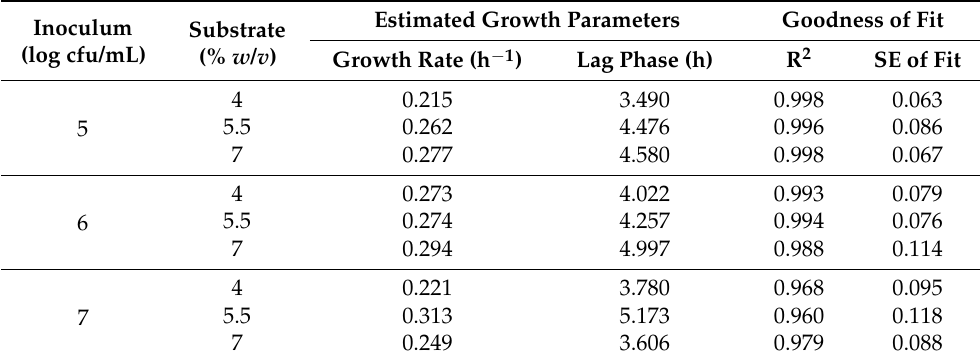
Table 2. DMFit estimated kinetic growth parameters of LA6 in 24-h fermentation at 30 ◦ C.